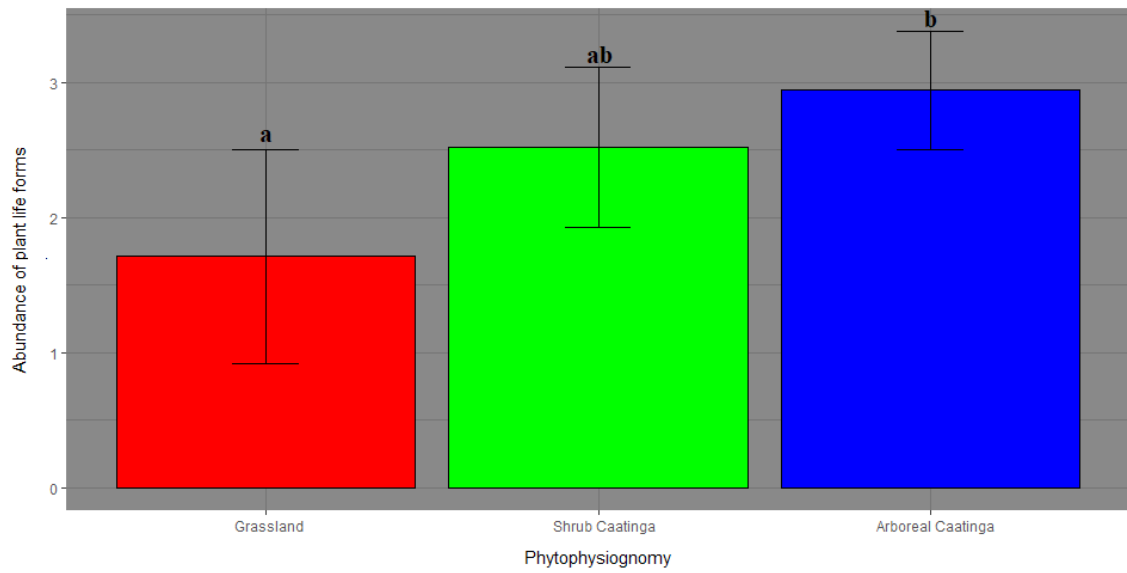
Fig 2. Variation in the abundance of plant life forms between the phytophysiognomies of Caatinga biome, Bahia State, Brazil . Grassland (low complexity), Shrub Caatinga (medium complexity), Arboreal Caatinga (high complexity). Different letters indicate significant difference between the phytophysiognomies (p ≤